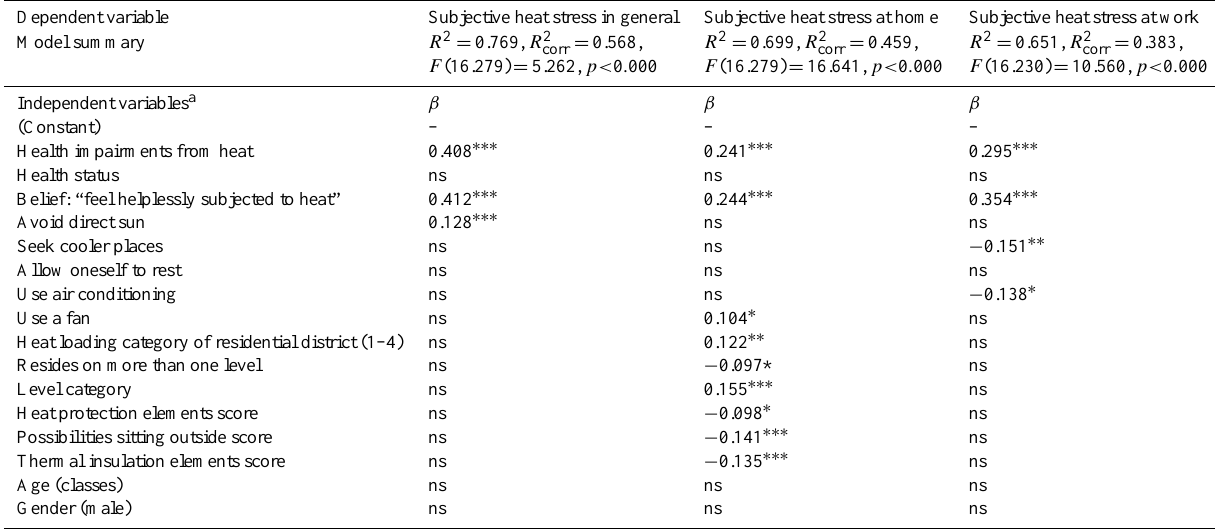
Table 6. Determinants of subjective heat stress (multiple regression). Dependent